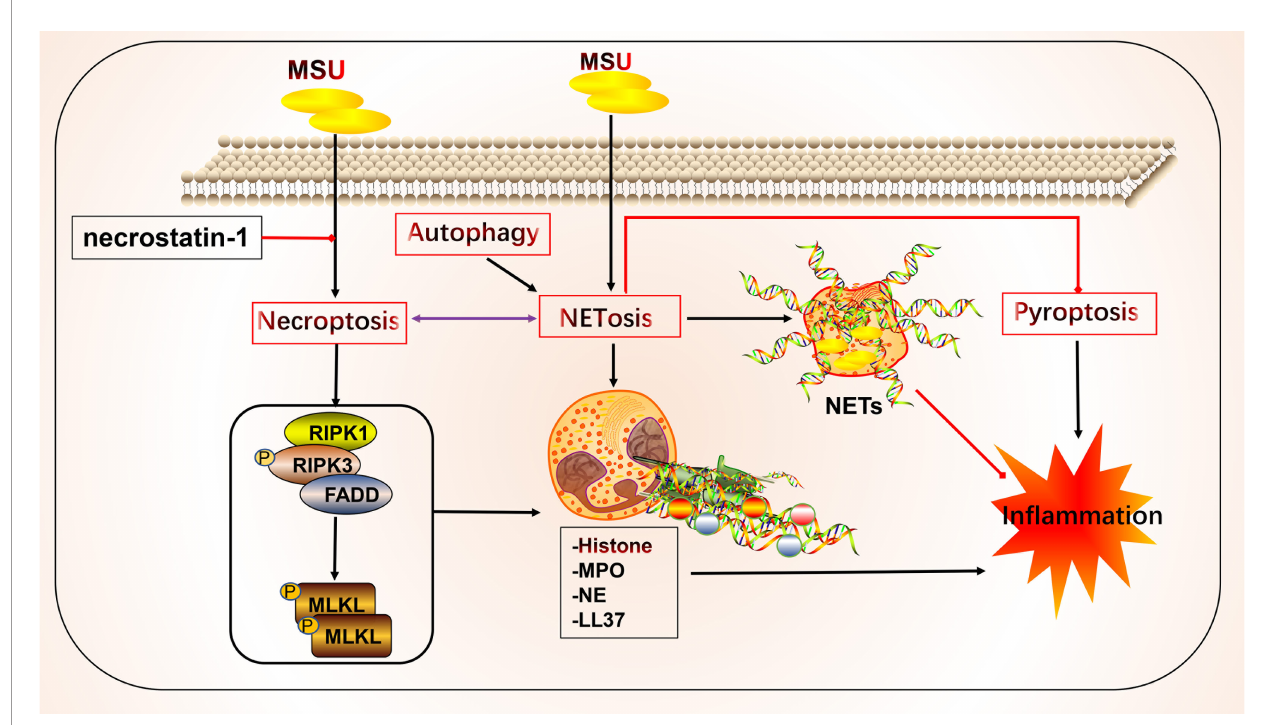
FIGURE 3 | Crosstalk of NETosis with other forms of cell death and implications for gout. Monosodium urate (MSU) -stimulated NETs require key molecules involved in necroptosis. Neutrophils can promote cytokine degradation by forming NETs, phagocytosing MSU, and physically isolating them to suppress in fl ammation. Histones released during NETosis may have cytotoxic and immunostimulatory effects on cells. In addition, crosstalk with other forms of cell death, including pyroptosis and autophagy, may